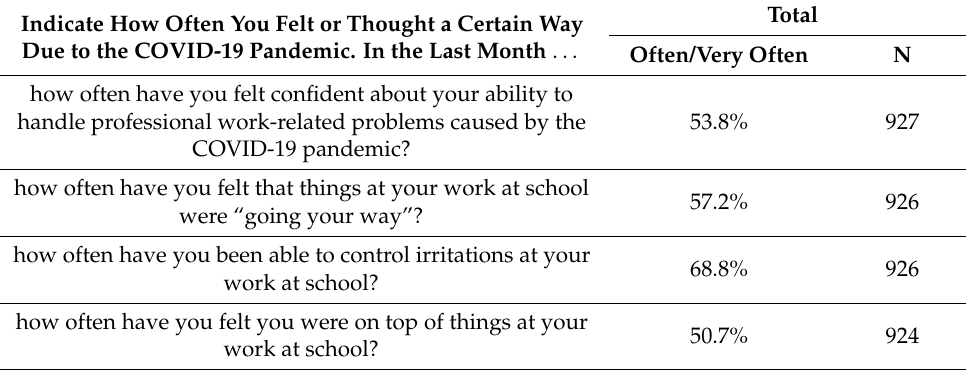
Table 2. Frequency of the PSE of Polish school principals during the COVID-19 pandemic.